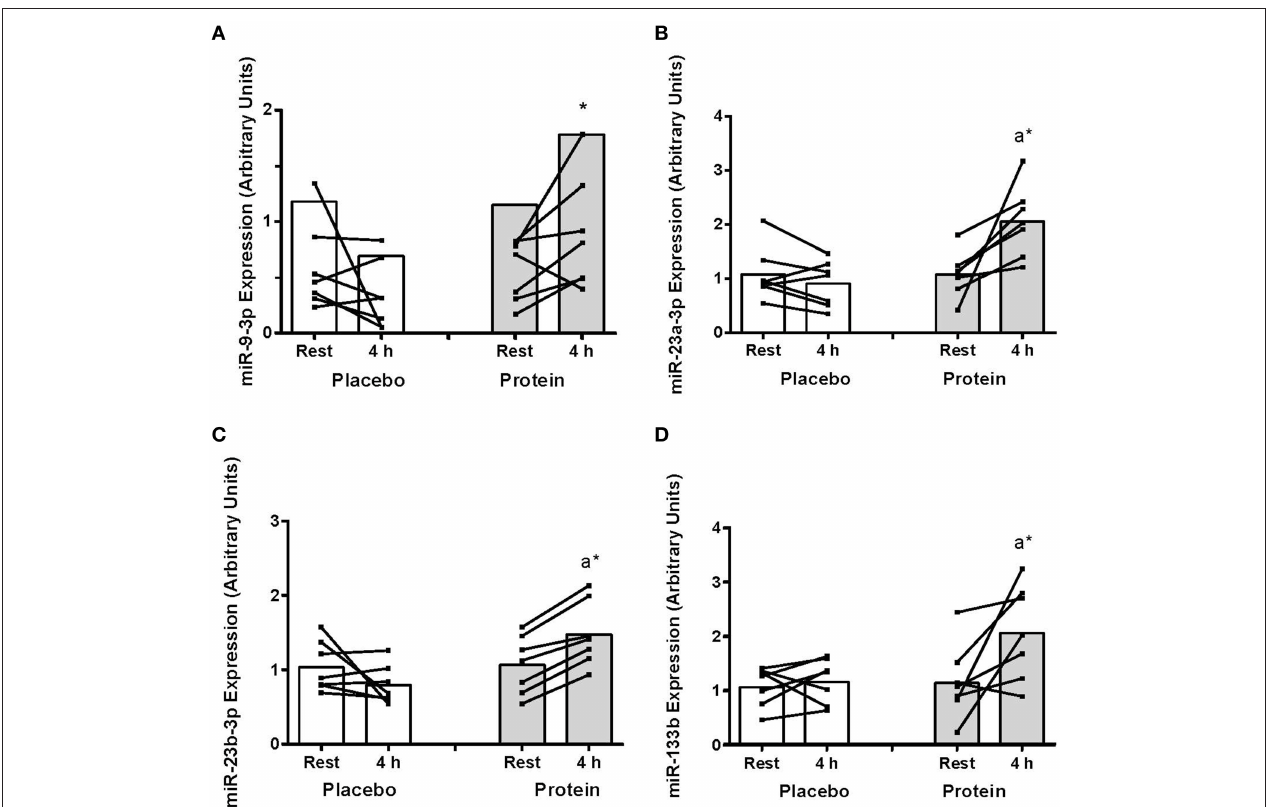
FIGURE 1 | (A) mir-9-3p, (B) miR-23a-3p, (C) miR-23b-3p, and (D) miR-133b abundance at rest and at 4h post-exercise recovery following a concurrent exercise session of resistance (8 sets of 5 leg extension at 80% 1-RM) and endurance (30min cycling at 70% VO 2peak ) exercise and ingestion of either 500-mL PLA or PRO beverage immediately after exercise. Values are arbitrary units expressed relative to RNU48 and presented as individual data with group mean ( n = 7 ). Significantly different ( P < 0.05 ) vs. (a) rest and ( * ) between treatments (PLA vs.